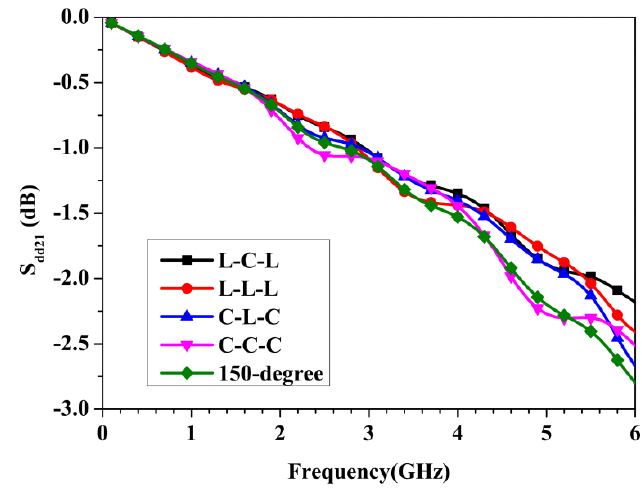
Figure 11. Simulated results of Sdd21.